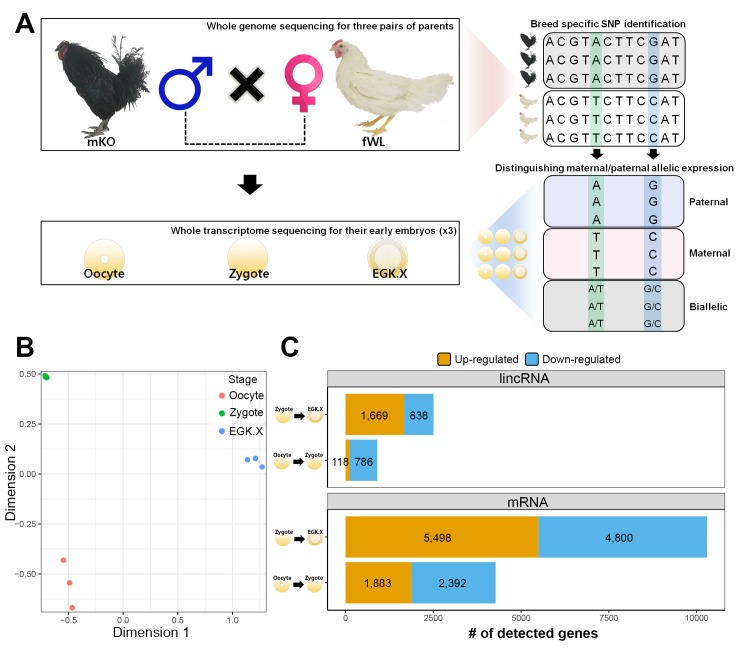
Whole-transcriptome analysis of single early chicken embryos.(A) Schematic diagram of the experimental design using a multiomics approach to assess allelic expression. Three pairs of parental male Korean Oge (mKO) and female White Leghorn (fWL) chickens were subjected to whole-genome sequencing. Hybrid single embryos between mKO and fWL at the oocyte, zygote and EGK.X stages from each parent were subjected to whole-transcriptome sequencing. Allelic expression in the hybrid embryos was examined on the basis of breed-specific SNPs. (B) Multidimensional scaling (MDS) plot based on log2 trimmed mean of M-value (TMM) normalised gene expression of the whole transcriptome in pre-oviposited chicken embryos. Biological triplicates of single embryos were clustered, and three developmental stages were distinct. (C) Number of significantly detected long transcripts (mRNAs and lincRNAs) detected by comparing gene expression among single oocytes, zygotes and EGK.X embryos (FDR-adjusted p<0.05).